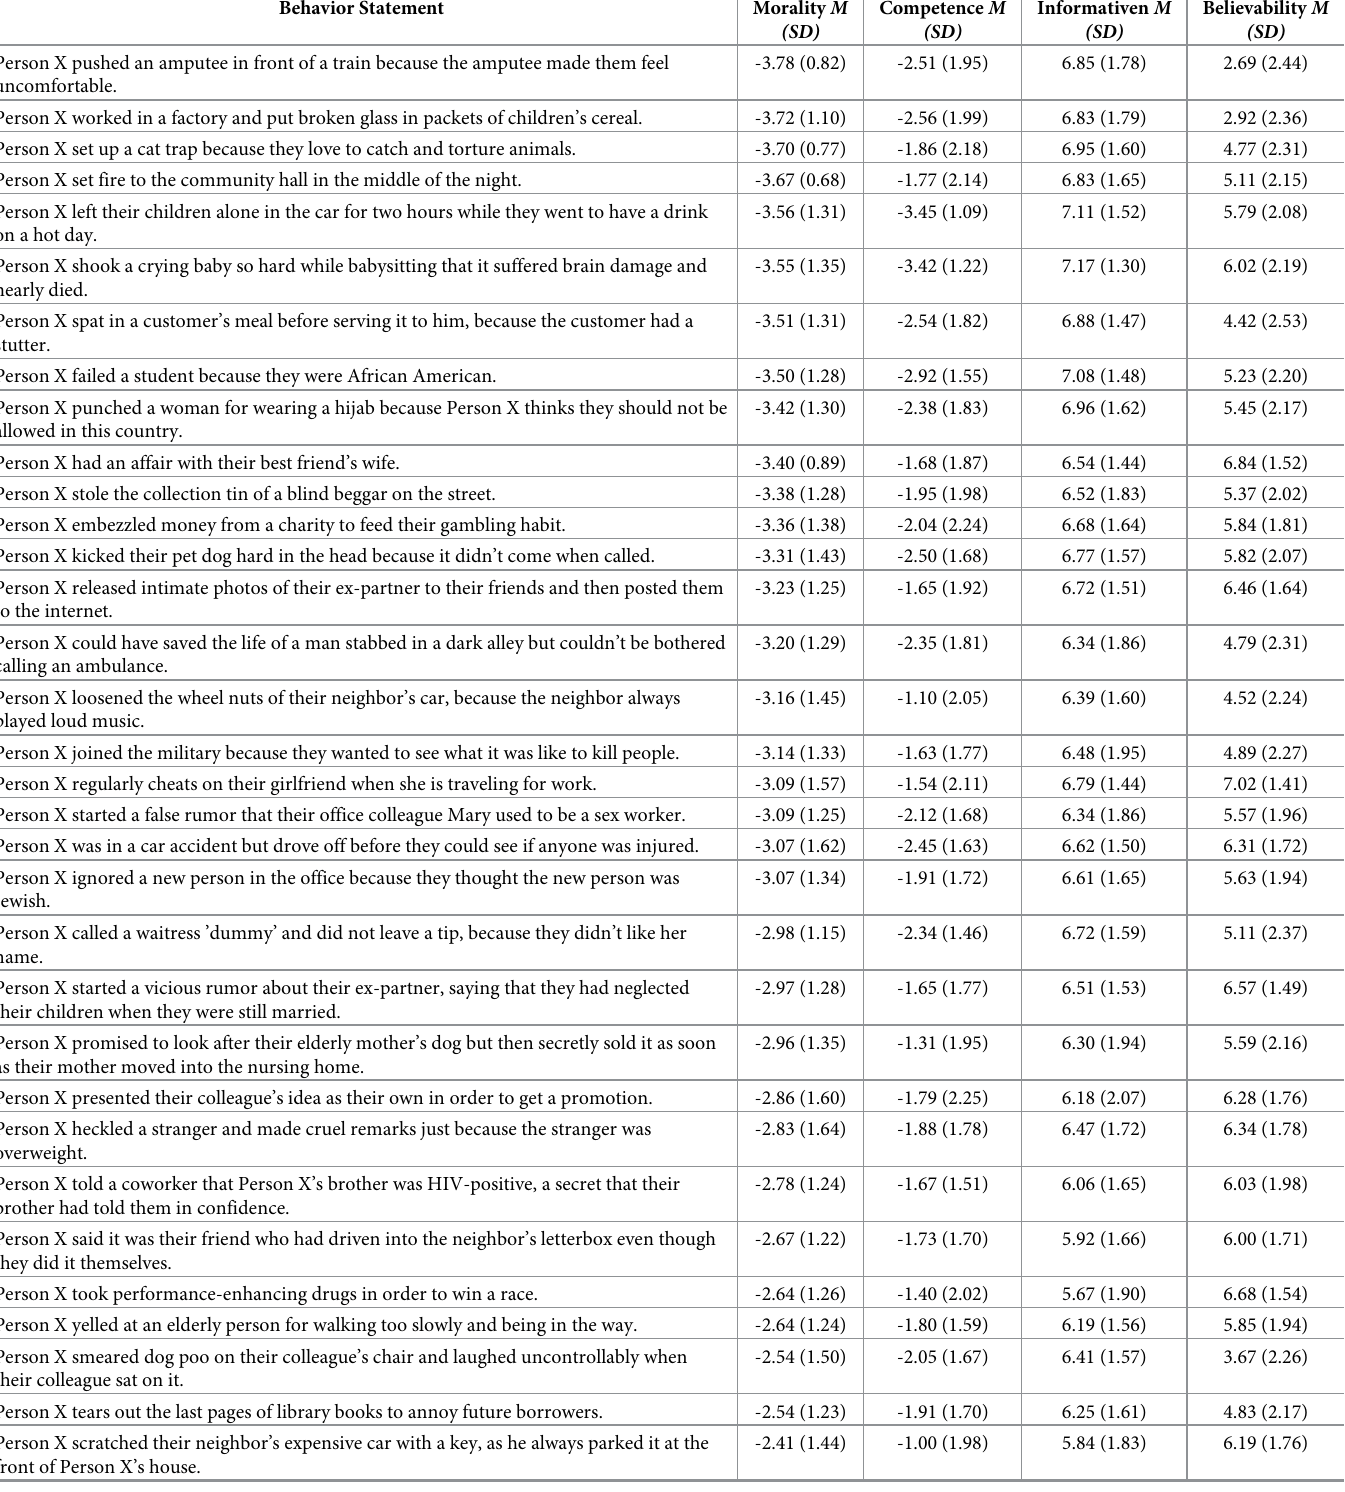
Table 1. Mean and standard deviations of morality, competence, informativeness, and believability ratings by behavior statement.